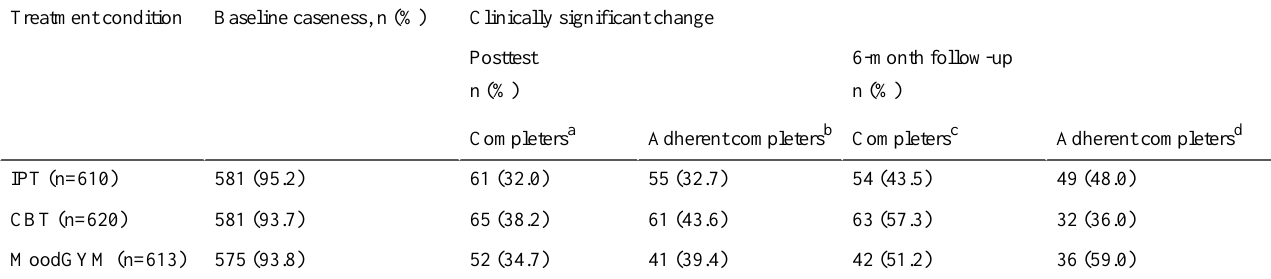
Table 4. Proportion of participants reaching the criteria for clinically significant change (score <22) on the Center for Epidemiological Studies Depression scale